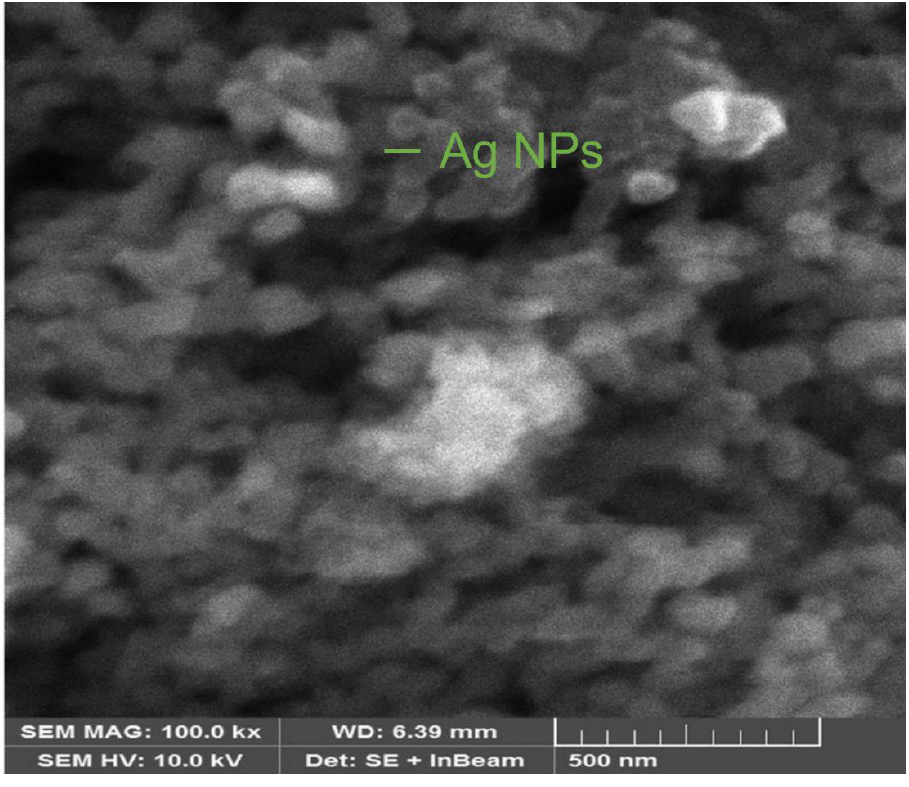
Figure 5 Scanning electron microscopy of biogenic Ag NPs. Figure 5. Scanning electron microscopy of biogenic Ag